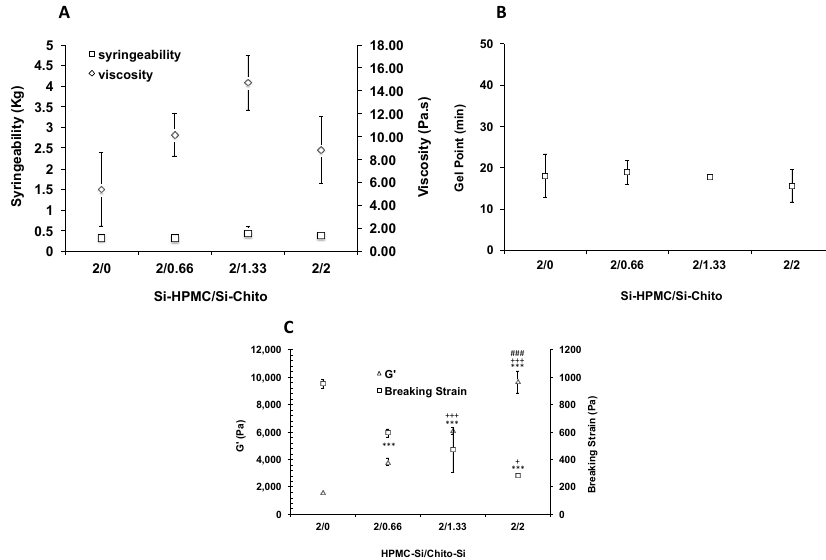
Figure 2. ( A ) Graph representing the injectability (normal force required to eject the solution out of the syringe with a needle (square)) and the viscosity of the silanized chitosan and silanized HPMC mixed solution (diamond). ( B ) Graph representing the gel point (normal force required to eject the solution out of the syringe with a needle (square) and without a needle. ( C ) Graph representing the combined evolution of the storage modulus (G ′ , triangle) and the breaking strain ( σ , square) with an increasing concentration of Si-chitosan. *** p < 0.001 compared to the 2/0 condition . + p < 0.05 compared to the 2/0.66 condition. +++ p < 0.001 compared to the 2/0.66 condition. ### p < 0.001 compared to the 2/1.33 condition.